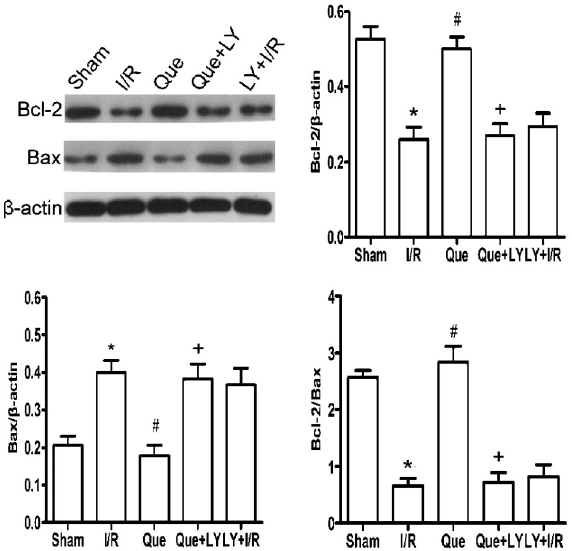
Figure 4. Effect of Que postconditioning on Bcl-2 and Bax expression after myocardial I/R injury (n=5). Data are reported as means±SD. Que: quercetin; I/R: ischemia/reperfusion; LY: LY294002. *P , 0.05 vs sham group, # P , 0.05 vs I/R group, + P , 0.05 vs Que group (one-way ANOVA followed by the Bonferroni test).